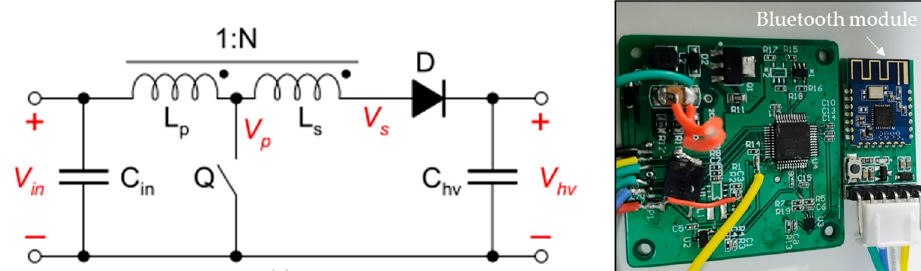
7 of 13 Figure 4. Manufacturing of piezoelectric actuator: ( a ) structure of the piezoelectric actuator; ( b ) cur- ing model of the piezoelectric actuator; ( c ) arrayed manufacturing of actuator. 2.3. Miniature Boost Actuate Circuit and Wireless Control Software The driving voltage of the piezoelectric driver needs to reach hundreds of volts. To generate the high-voltage signals required to drive the piezoelectric actuator, we designed and fabricated a custom lightweight boost converter circuit that can convert a low-voltage (12 V) direct-current (DC) input signal into a signal in the range of 12 to 250 V. The main components of the circuit, shown in Figure 5, are a single-chip microcomputer, switch interfacing circuit (IC), field-effect tube, inductor, operational amplifier, and diode. The